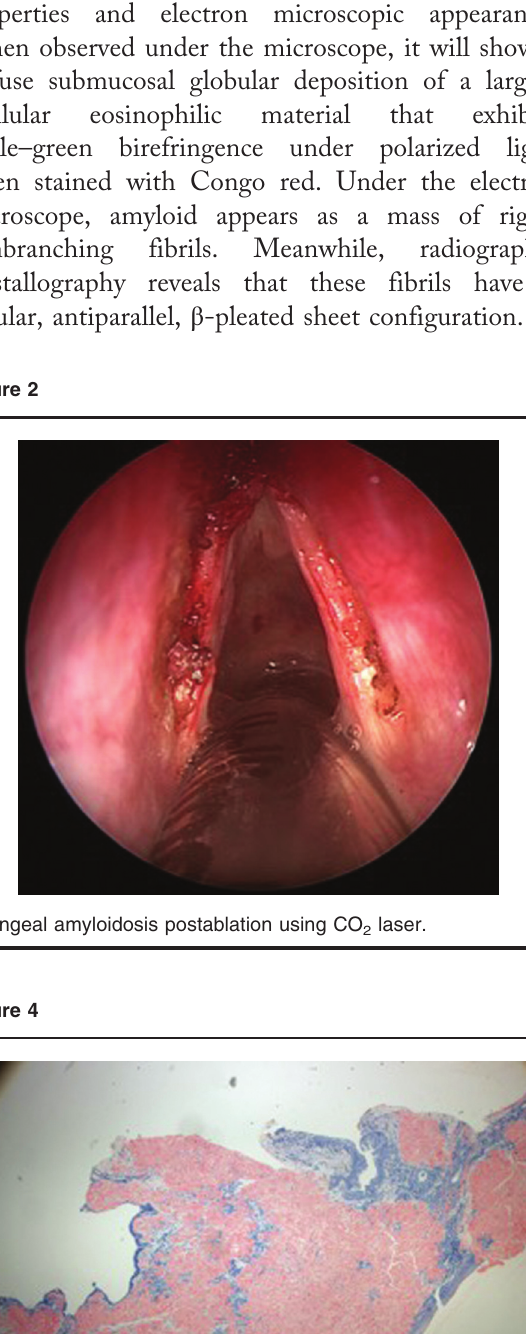
Histologic examination showing homogenous eosinophilic deposits in the stroma.